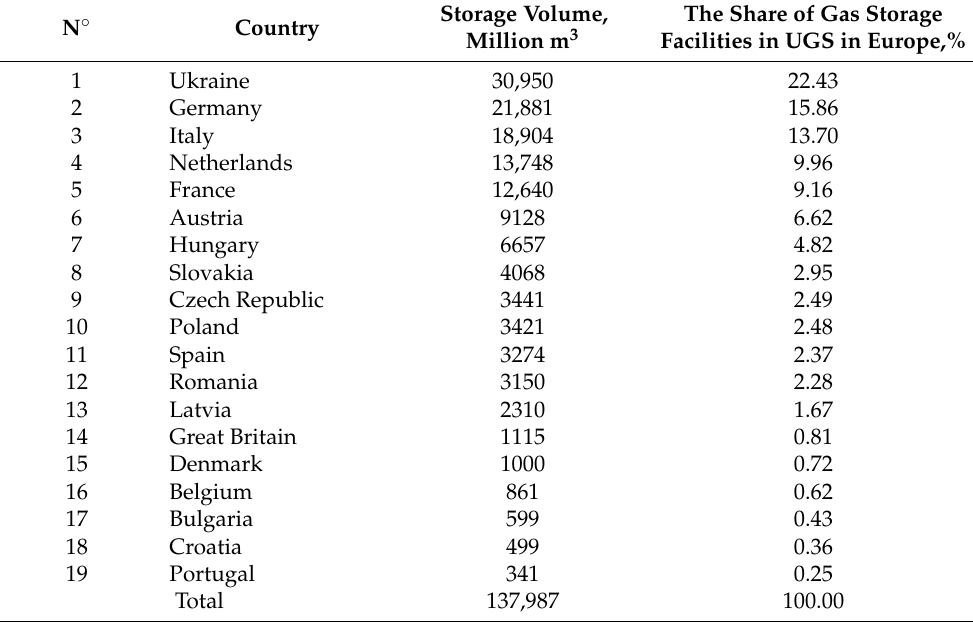
Storage Volume, The Share of Gas Storage Million m 3 Facilities in UGS in Europe,%